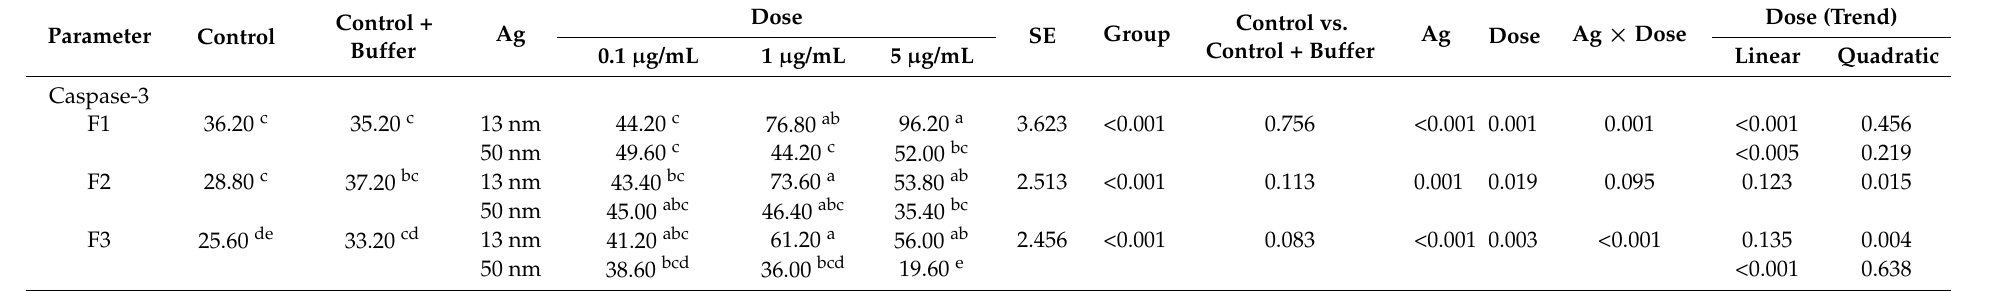
Table 1. Caspase-3 activity in the granulosa cells isolated from preovulatory (F3-F1) follicles after 24 h of incubation with increased concentrations of 13 nm and 50 nm AgNPs.